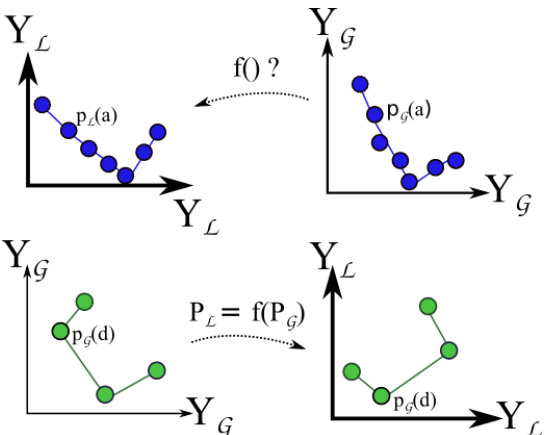
Figure 12. Transformation f () , from GNSS to LOAM coordinate system ( P L = f ( P G ) ). Function P L = f ( P G ) is a composition of two